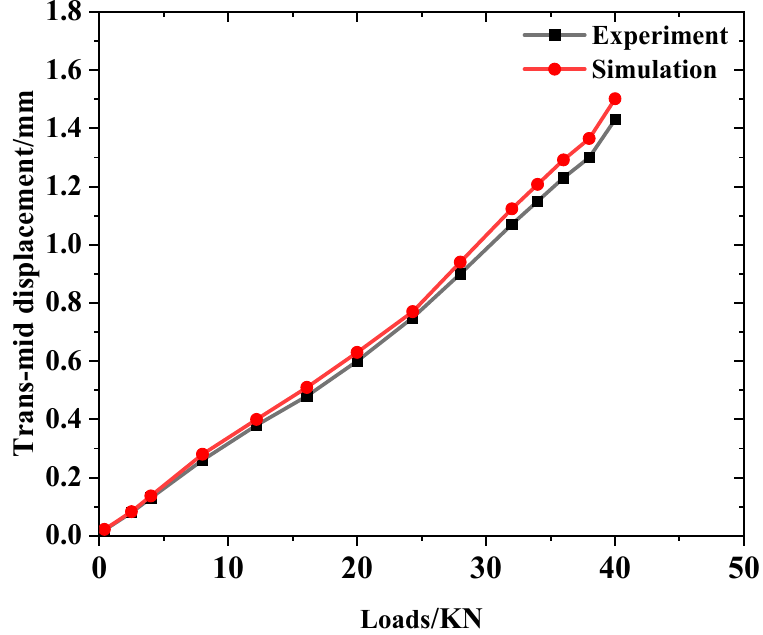
Figure 10. Numerical simulation of plain concrete frame and comparison of span displacement of frame structure test.